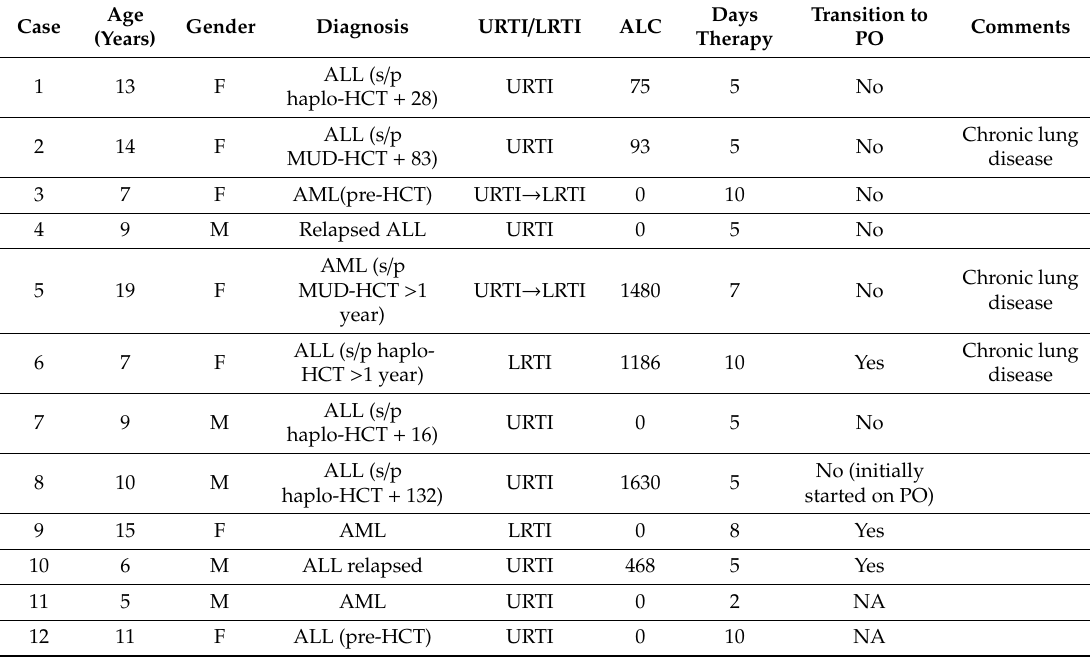
Table 1. Clinical characteristics of patients with respiratory syncytial virus (RSV) infection treated with inhaled